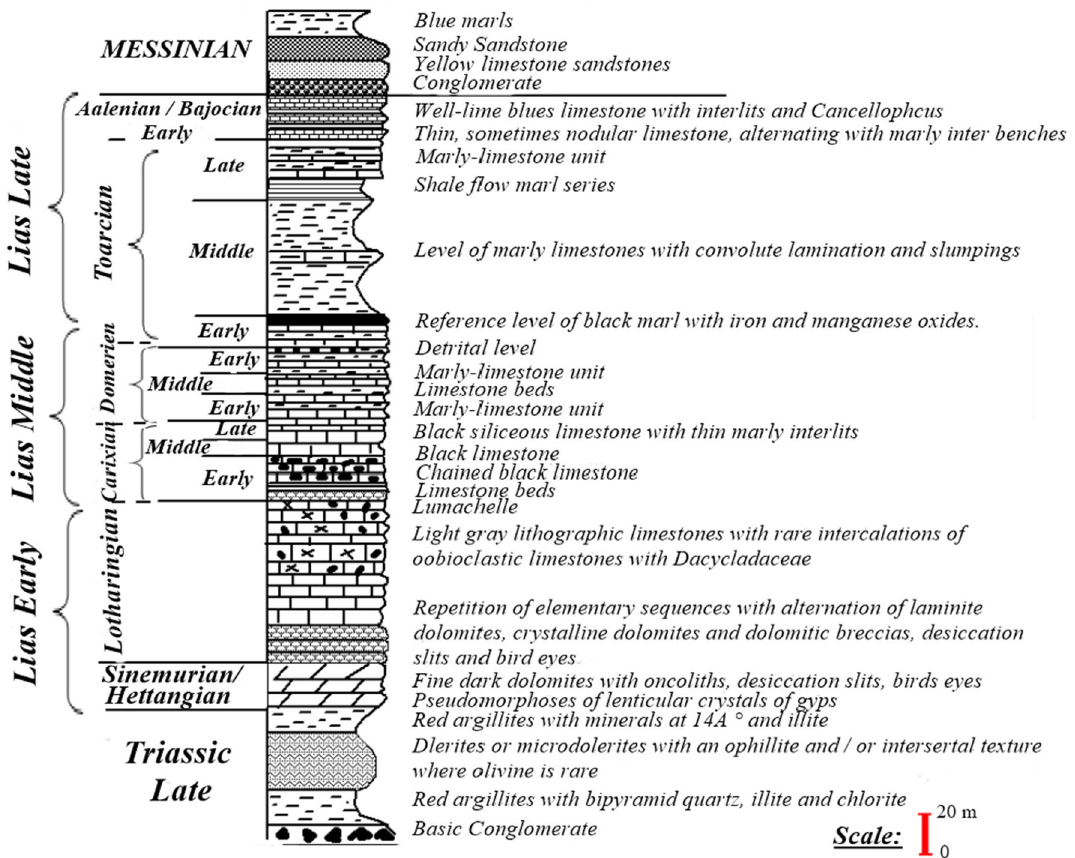
Fig. 3 Colonne stratigraphique synthétique du massif de Tazekka (Auajjar and Boulegue,